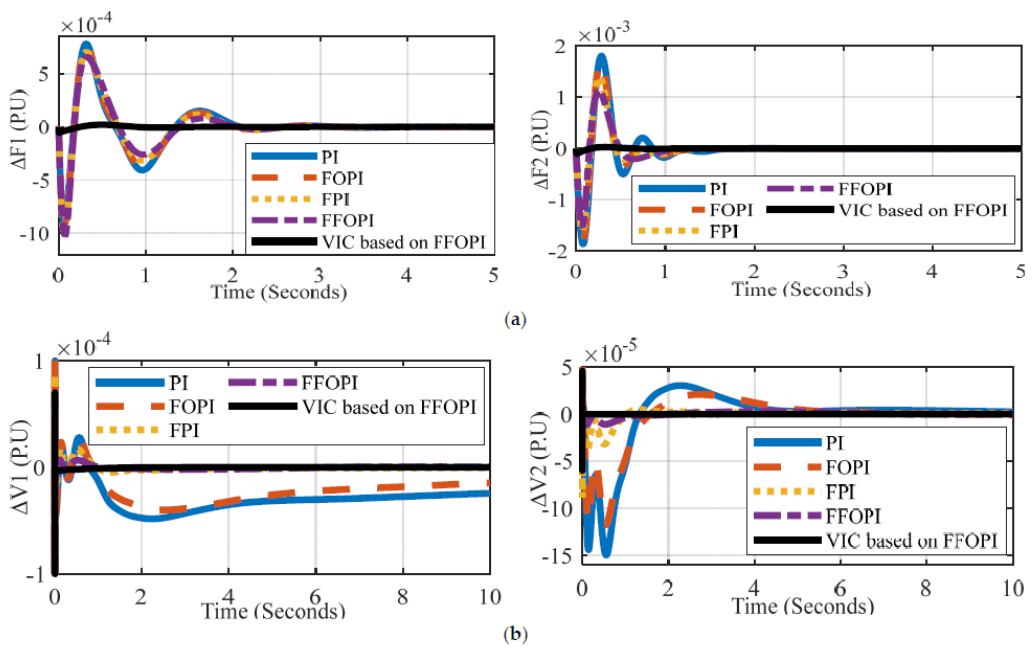
Figure 15. Interconnected microgrid’s frequency and voltage measurements versus time for each controller at solar radiation disturbance: ( a ) ∆ F 1 (P.U), ∆ F 2 (P.U), ( b ) ∆ V 1 (P.U), ∆ V 2 (P.U). Table 12. Dynamic specification of frequencies and voltage deviation for each controller at solar radiation disturbance.